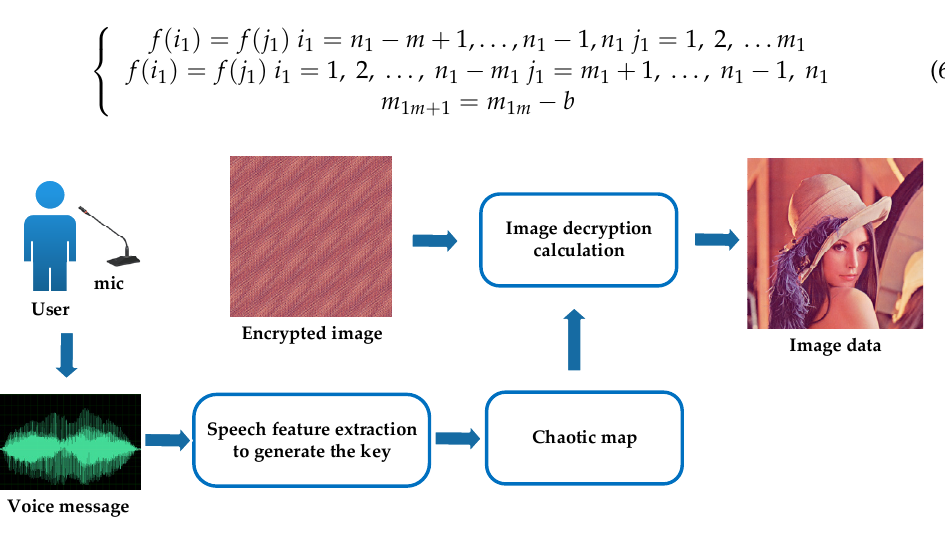
Figure 4. Decryption